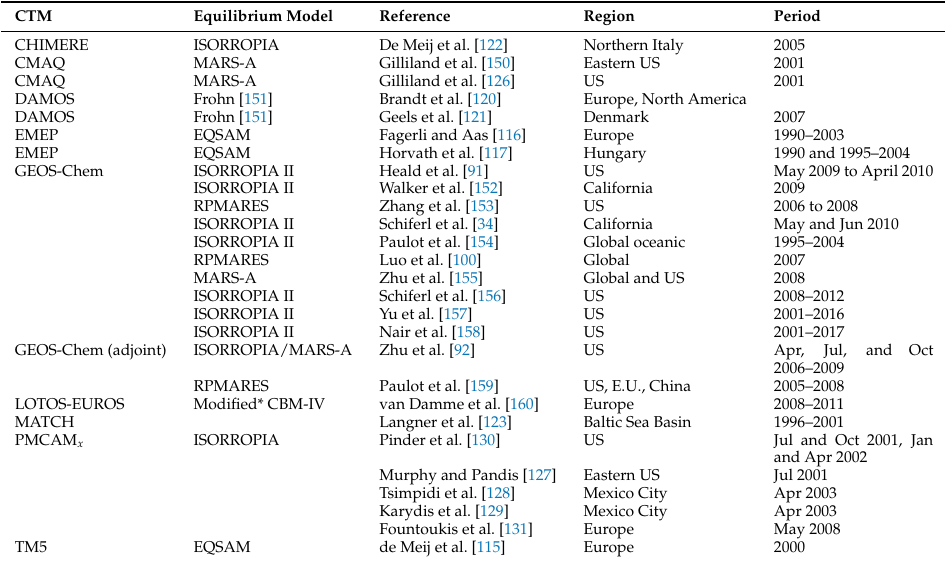
Table 3. Some modeling studies of atmospheric [NH 3 ] using Eulerian chemical transport models.